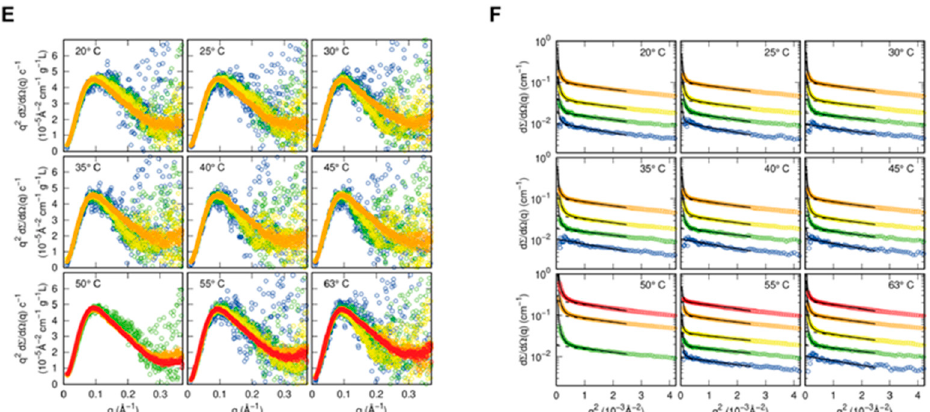
Figure 3. Structural characterization of S. solfataricus aIF5A in solution: ( A ) The structures of modeled S. solfataricus aIF5A superimposed on P. arophilum aIF5A (PDB ID 1BKB) are shown in gray and light coral, respectively. The RMSD estimated between the C- α atoms of the structures is 0.120 Å; ( B ) 3D topology of S. solfataricus aIF5A modeled structure. The molecular structure is colored from the N-terminus (dark blue) to the C-terminus (red). In the depiction the location of the lysine 36 that is normally hypusinated is highlighted; ( C , D ) SAXS curves shown in log–log plots of the N-His-aIF5A. Each frame reports data at the same temperature, as indicated. The protein concentration of each sample is: 0.5 mg/mL (blue); 1 mg/mL (green); 2 mg/mL (yellow); 5 mg/mL (orange); 10 mg/mL (red). Samples in panel C contain 60 mM KCl, and the ones in panel D contain 1000 mM KCl. Error bars are reported every 10 points, for clarity Solid black lines are the best fit obtained with GENFIT (Equation (S7)); ( E ) Kratky plots of data reported in panel C . Curve have been divided by the protein concentration; ( F ) Guinier plot of data reported in ( C ). The solid black lines in panel f are the best Guinier/Porod fits (Equation (S1)), whereas the dashed black lines are the Guinier law contribution (first term of Equation (S1)). Kratky and Guinier plots of data corresponding to panel D are shown in Figures S3 and